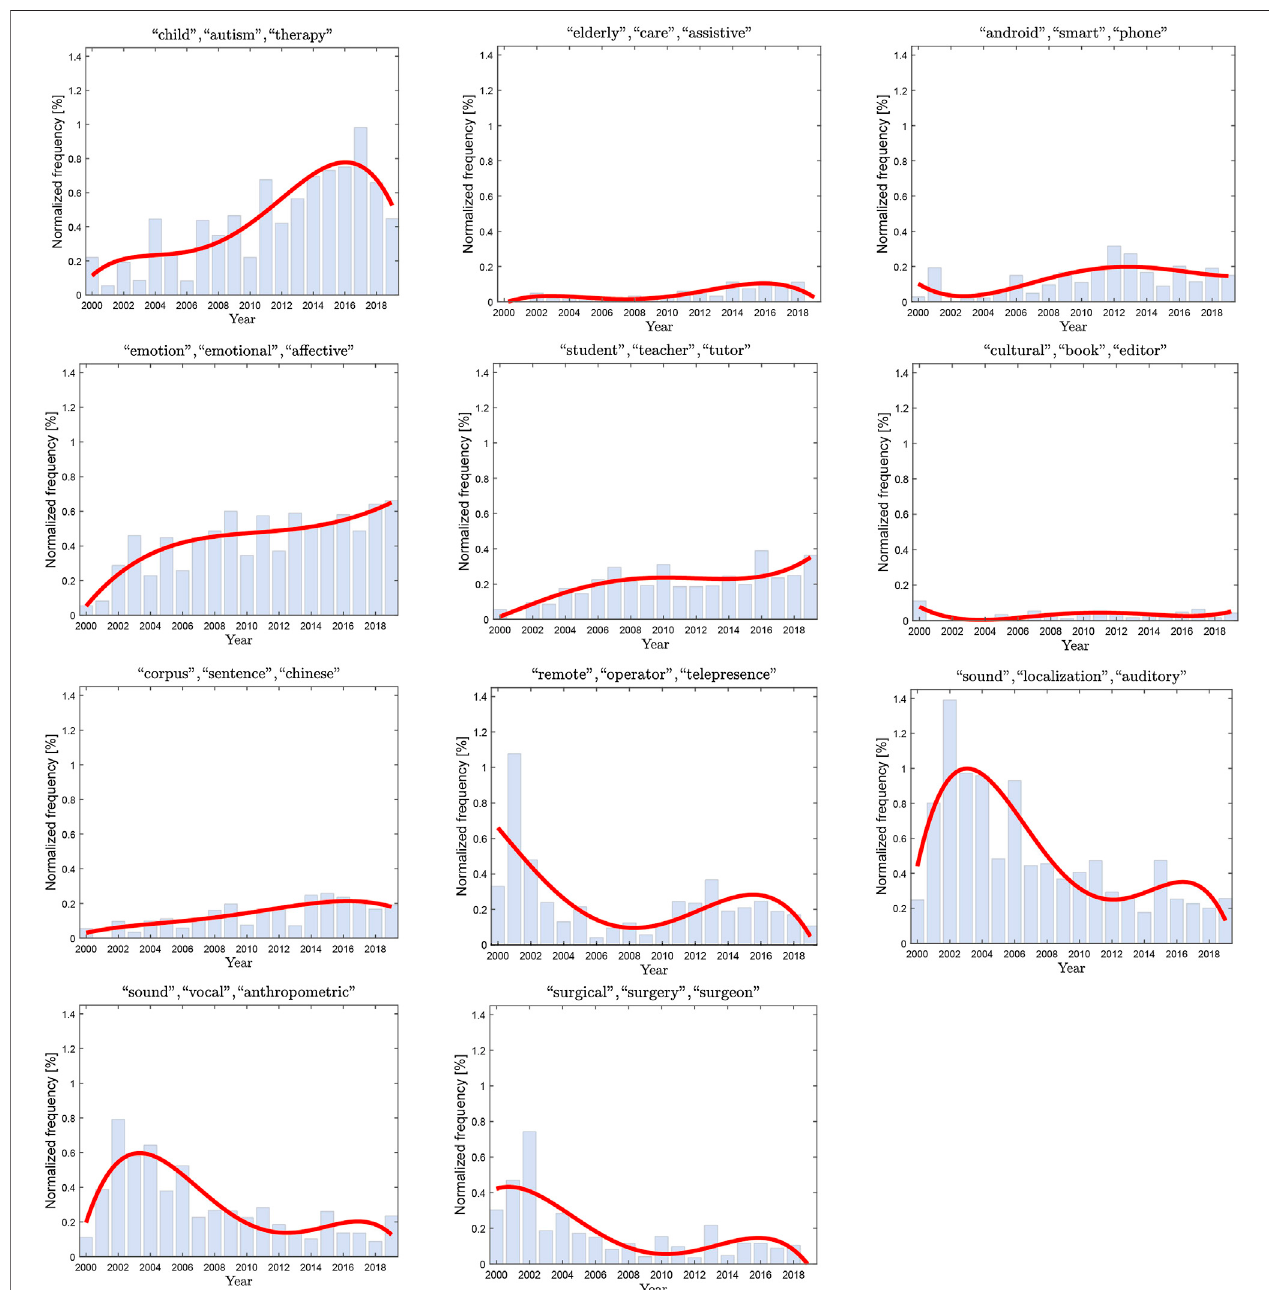
FIGURE 7 | Key – words trends of signi fi cant top topics normalized and compared to the overall number of words in the collection of document for each year.